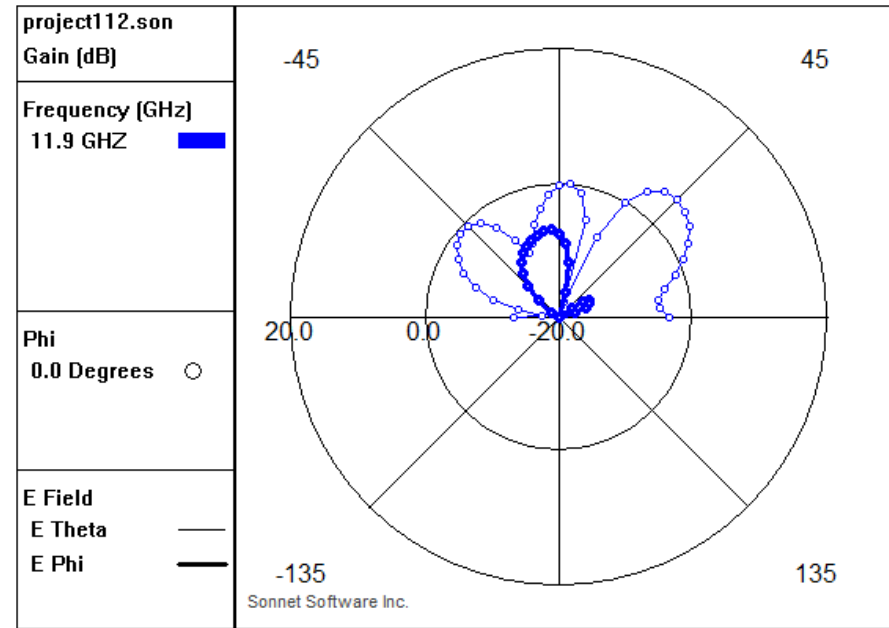
Figure 4. Radiation pattern of the antenna at 11.9 GHz